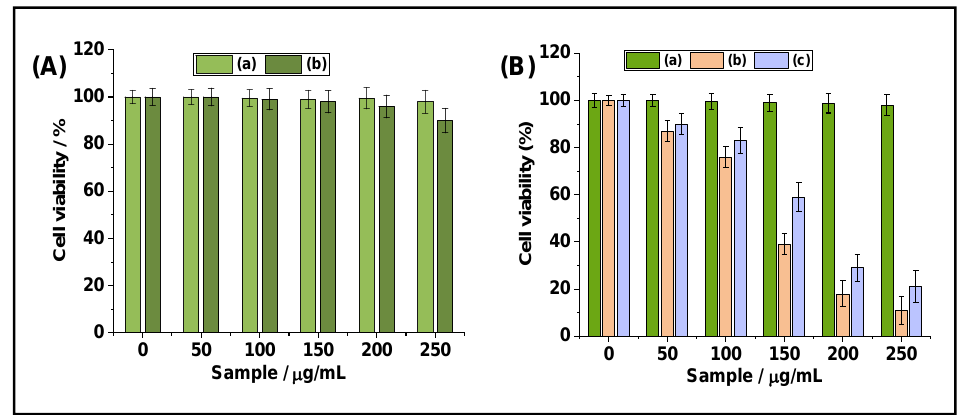
Figure 5. ( A ) In vitro biocompatibility of (a) control MDA-MB-231 cells; (b) FeNP@MSHC NPs without Dox loading, at different concentrations. ( B ) In vitro cytotoxicity of (a) control MDA-MB-231 cells; (b) FeNP@MSHC/Dox NPs; and (c) pure Dox sample, at different sample concentrations.